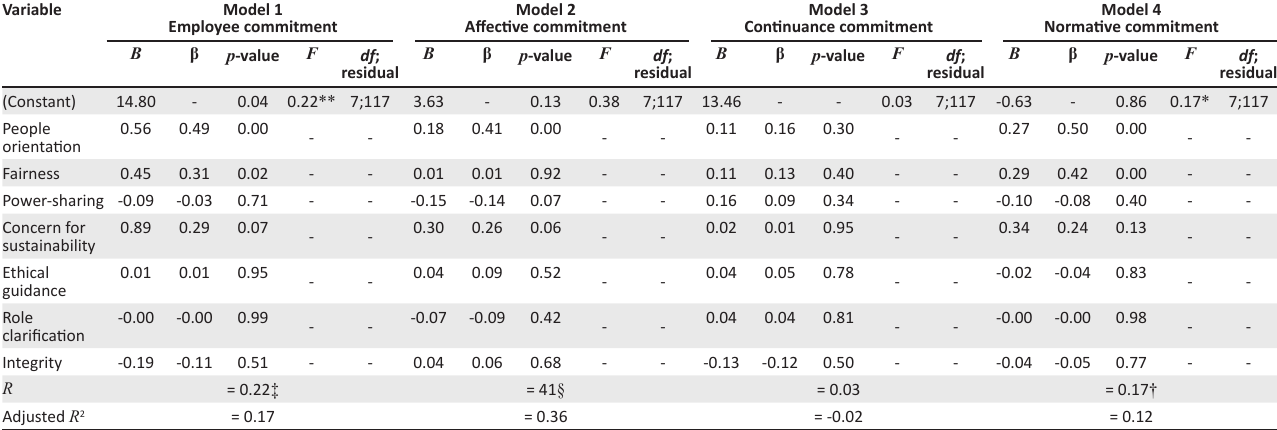
TABLE 3: Multiple regression analysis: Ethical Leadership Behaviour Questionnaire as a predictor of Organisational Commitment Scale ( N = 130).